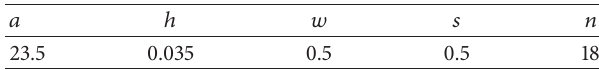
Table 2: Dimensions of coils used for measurements (in